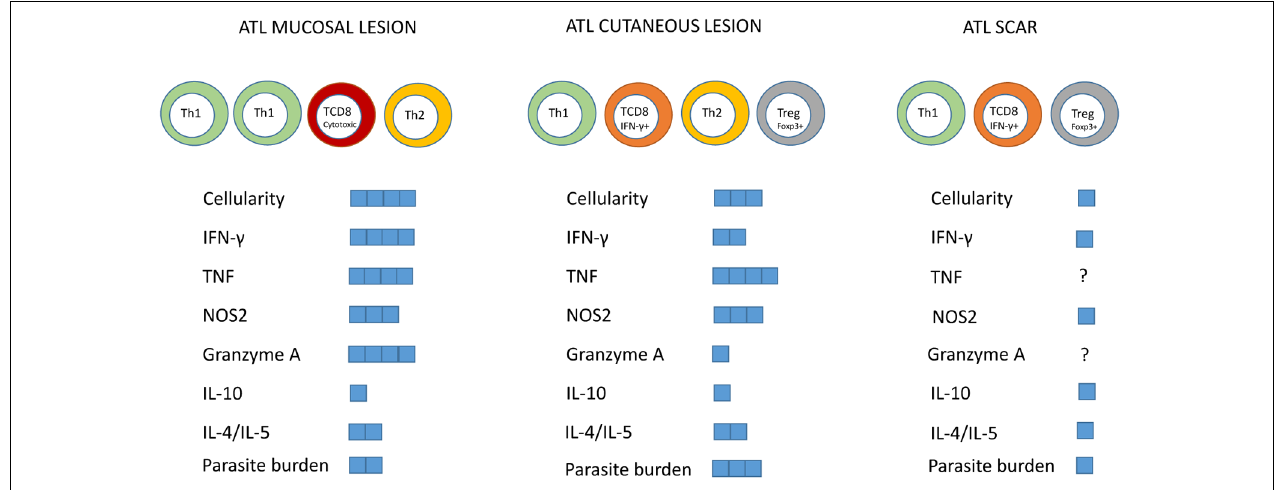
FIGURE 2 | Summary of the main immunological features described in mucosal lesions, localized cutaneous leishmaniasis and skin scars of tegumentary leishmaniasis. Predominant cell subtypes were indicated for each clinical form. The blue squares represent the intensity of the parameters indicated in the figure.